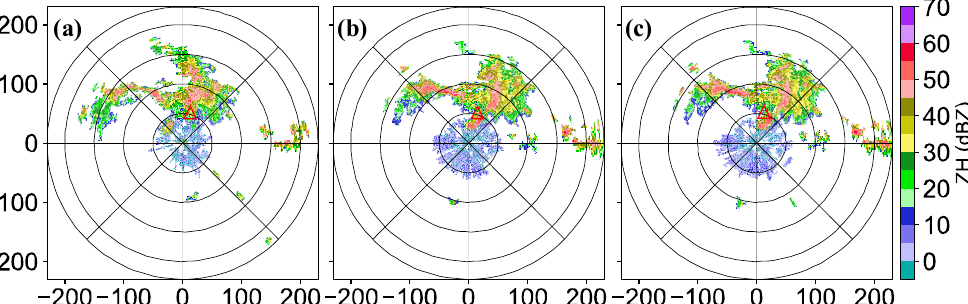
Figure 15. The 0.5° PPI of reflectivity of the Hefei radar at 0436 ( a ), 0522 ( b ), and 0528 LST ( c ) on 29 June 2015, in which the red triangle is the location of the disdrometer at Dingyuan.